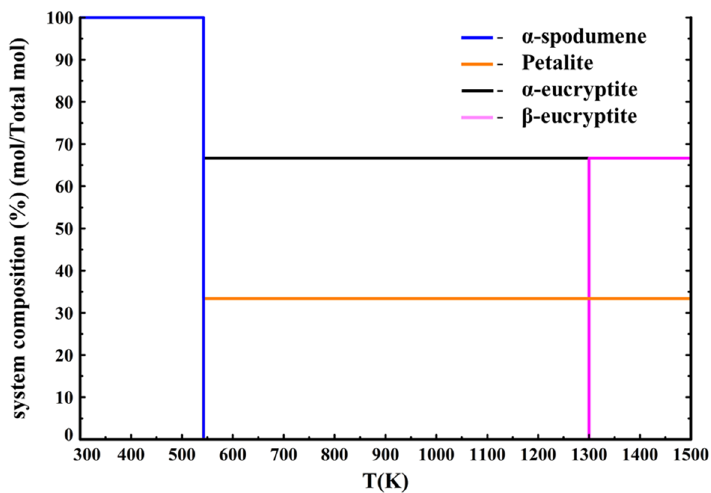
Figure 11. Phase diagram of spodumene using data from Barin [33] for the four-element system (Li + Al + 2 Si + 3 O 2 ).